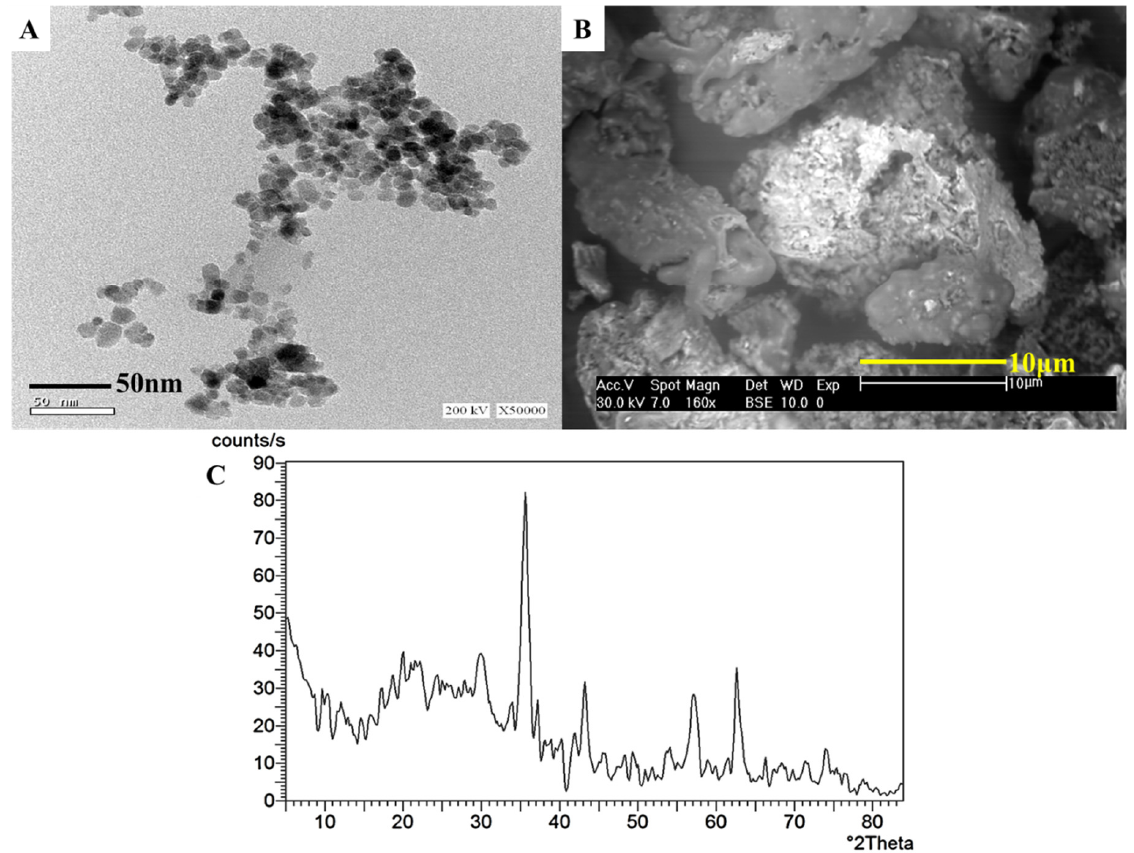
Figure 1. Transmission electron microscopy (TEM) ( A ), scanning electron microscope (SEM) ( B ), and X-ray diffraction (XRD) ( C ) analysis of the MCa-ATA sorbent .